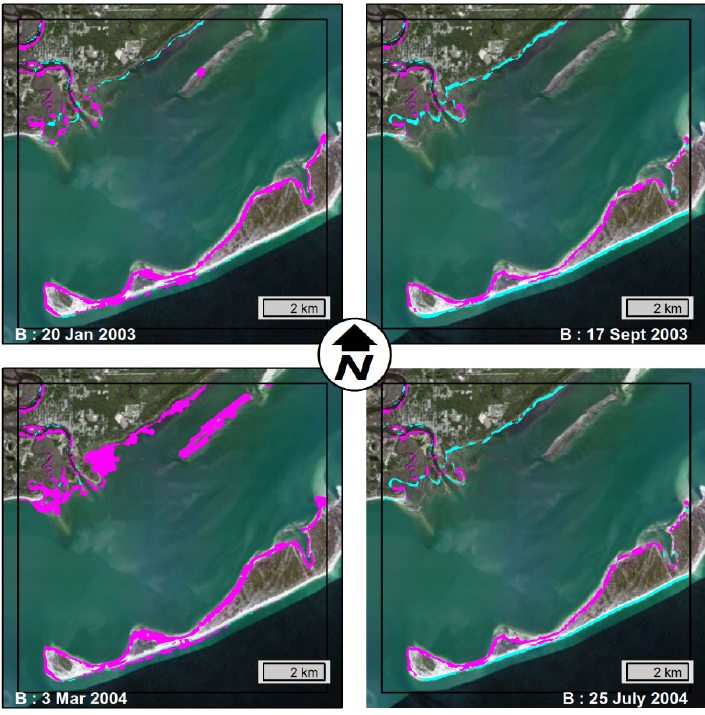
Figure 8. Synoptic inundation results for Assessment Area B (Carrabelle/Dog Island). Pixels incorrectly predicted as DRY are shown in magenta; pixels incorrectly predicted as WET are shown in cyan. Other areas within the square boundary were correct.